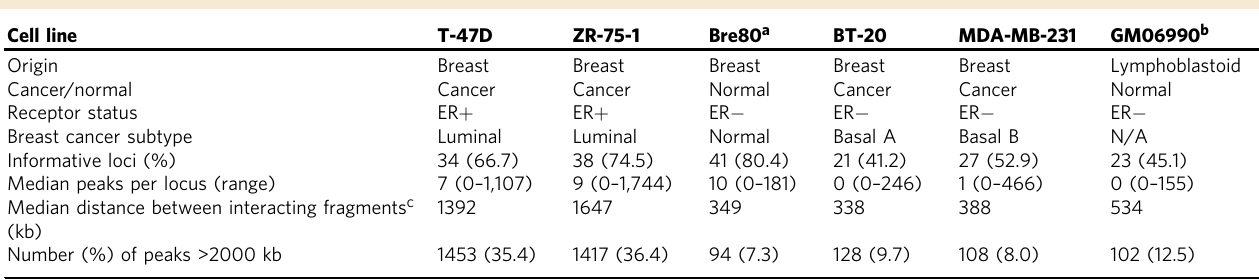
Table 1 Characteristics of 51 informative risk loci in six cell lines Cell